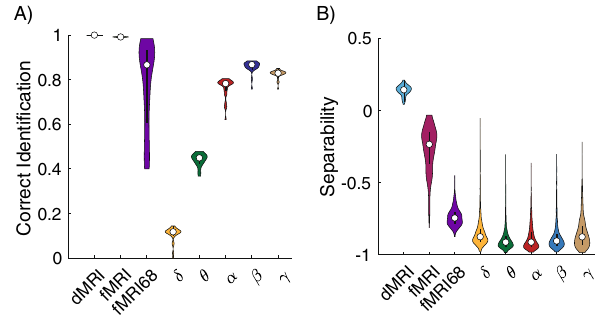
Figure 7. Fingerprinting performance across imaging modalities. ( A ) Proportion of networks that were correctly matched to the corresponding individual for dMRI, fMRI, and EEG derived brain networks. ( B ) Separability of each network in being matched to corresponding individual. fMRI indicates results using the Schafer 200 atlas whereas fMRI68 indicates results using the 68 regions Desikan-Killiany atlas. For each violin plot, the central dot indicates the median, and the line indicates the 25th–75th